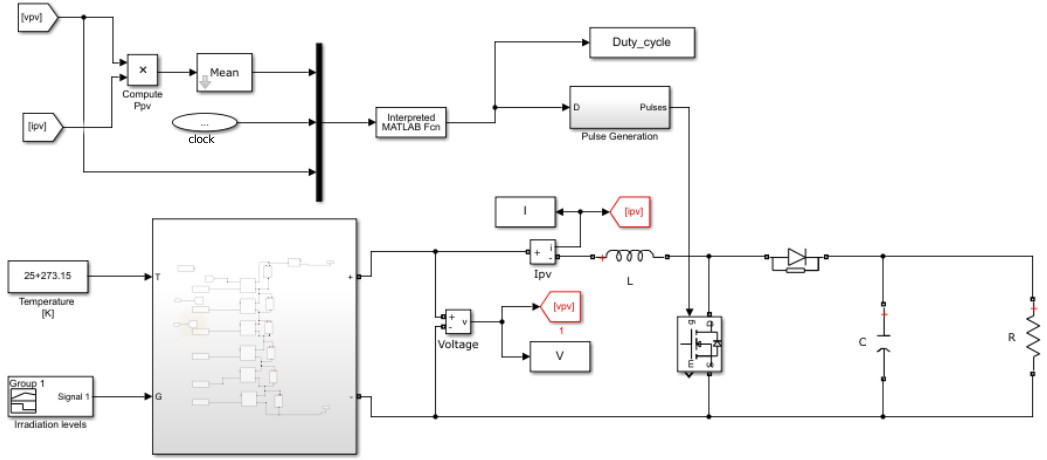
Figure 1. Matlab simulink scheme with boost